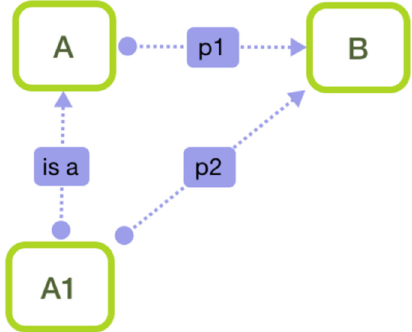
Figure 4. Special case 1 of is-a relation processing.